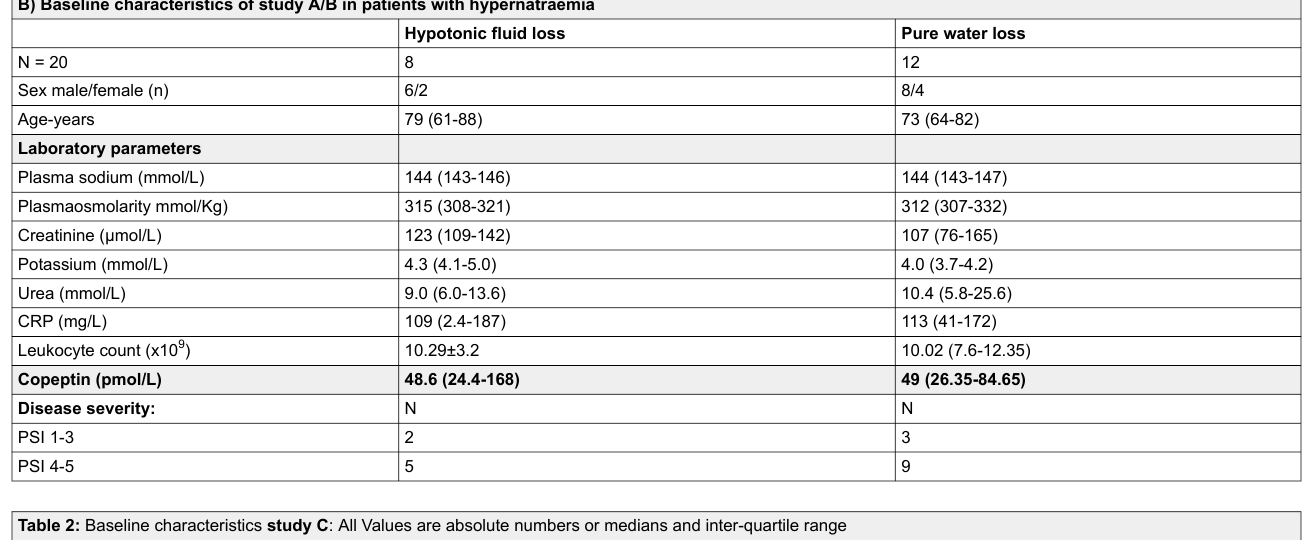
Table 2: Baseline characteristics study C : All Values are absolute numbers or medians and inter-quartile range A) Baseline characteristics of study C in patients with